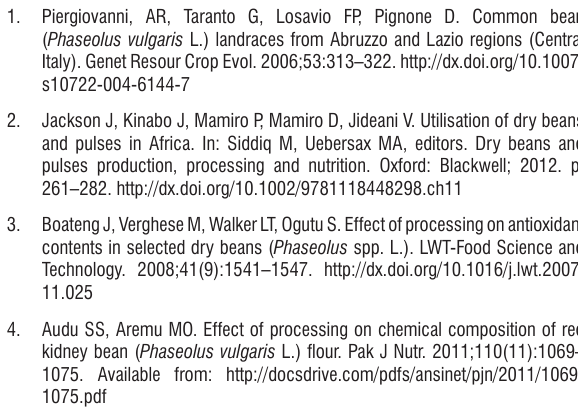
Improvement in quality of bean seed from different planting dates through hand sorting based on seed discolouration Germination improvement (%) Macrophomina spp .